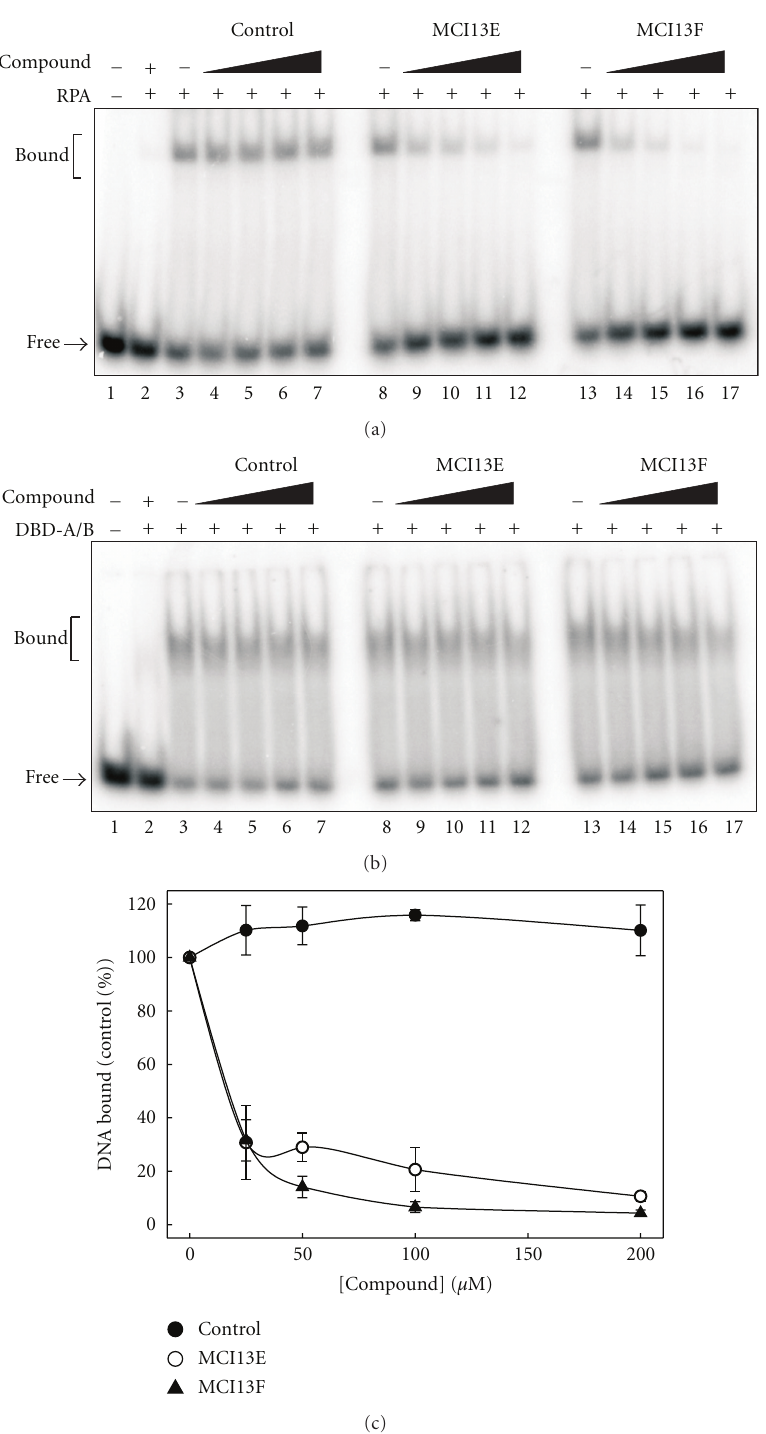
Figure 4: Inhibition of full-length heterotrimeric RPA but not DBD-A/B-DNA-binding activity by the MCI13 series of bicyclic isoborneol haloesters. The control used is a distillate of the reaction components of the synthesis of the MCI13 compounds diluted in equal concentration of DMSO as the MCI13, inhibitors. (a) Increasing concentrations of control compound, MCI13E, or MCI13F (25, 50, 100, and 200 μ M) were titrated in DNA binding reactions containing full-length heterotrimeric RPA. Binding to [ 32 P]-ss 30-base 3Pc3 DNA was assessed by EMSA as described in “Section 2.” (b) The same inhibitor concentrations were assessed in reactions measuring the binding of DBD-A/B to a 30-mer substrate. (c) Analysis of control, MCI13E, and MCI13F inhibition of full length RPA. Average of three independent experiments is shown with Standard Deviation as error bars. From this graph, IC 50 were calculated. MCI13E had a calculated IC 50 of 16 . 06 ± 2 . 78 μ M, while MCI13F had a calculated IC 50 of 10 . 11 ± 1 . 0 μ